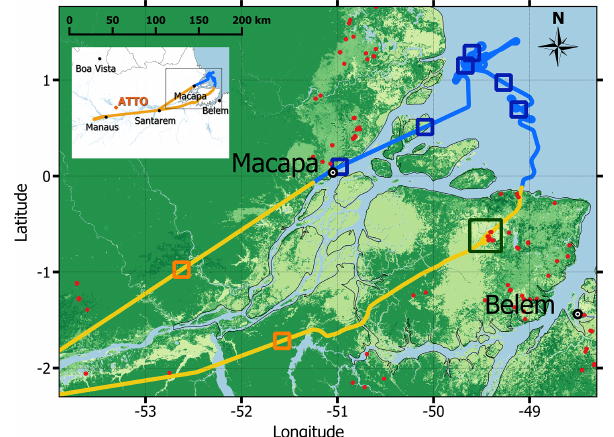
Figure 1. ACRIDICON-CHUVA flight AC19 on 30 Septem- ber 2014. The squares represent the locations at which the aircraft ascended or descended through the upper pollution layer (UPL) (blue: offshore profiles, orange: inshore profiles). The yellow and blue segments of the flight track correspond to the inshore and off- shore sections that were averaged to obtain the profiles in Fig. 3. Red markers indicate fire spots on 30 September 2014 as obtained from INPE (http://www.inpe.br/queimadas/bdqueimadas/, last ac- cess: 17 April 2019), and the dark green square represents the loca- tion where a fresh BB plume was probed at ∼ 1km altitude.